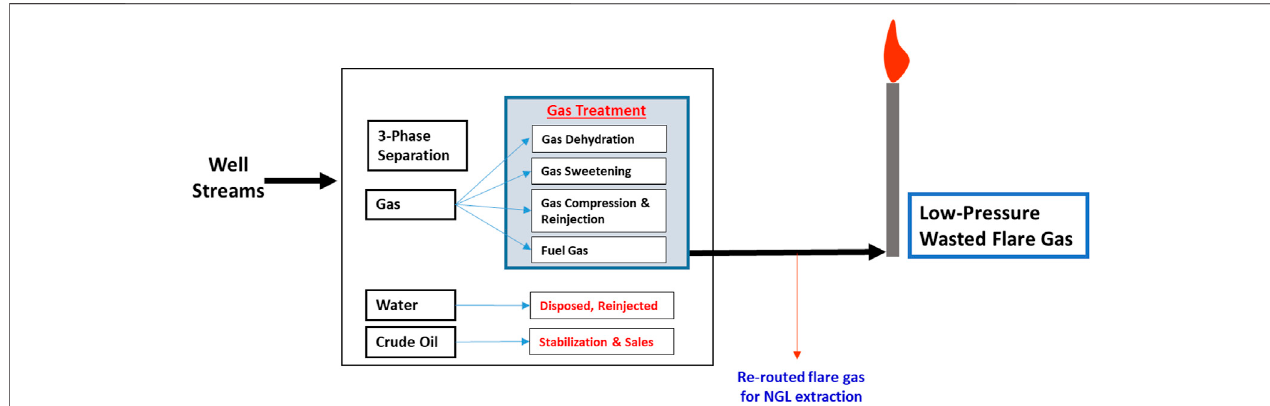
FIGURE 1 | Production process